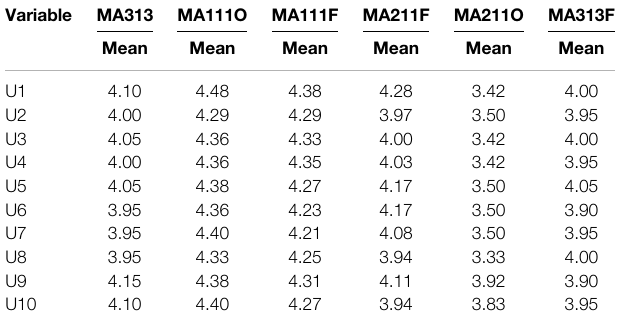
TABLE 7 | Students ’ perspectives on the